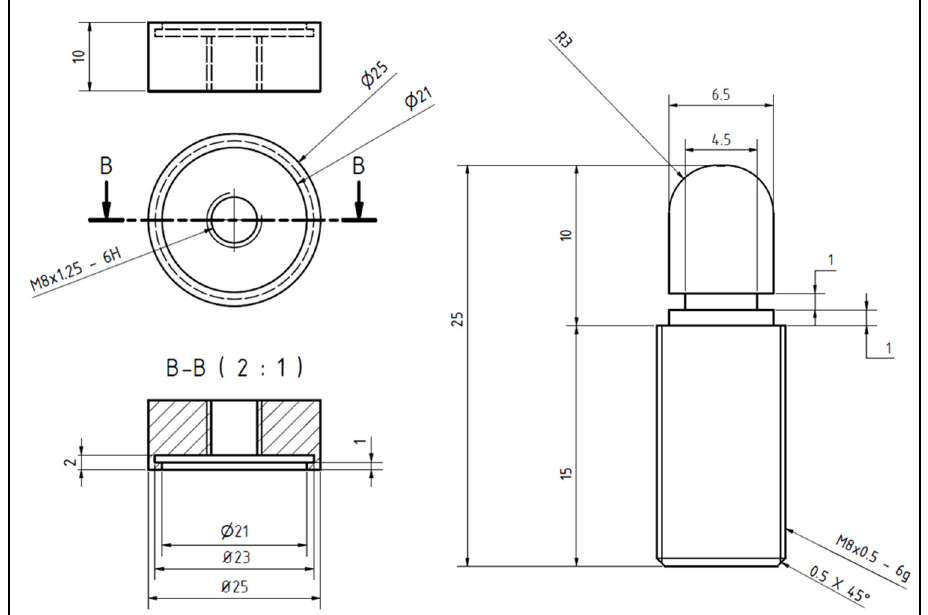
Figure 3. Technical drawing in mm of the test implant that was used in Group 1 (with undercuts/ cement pocket).